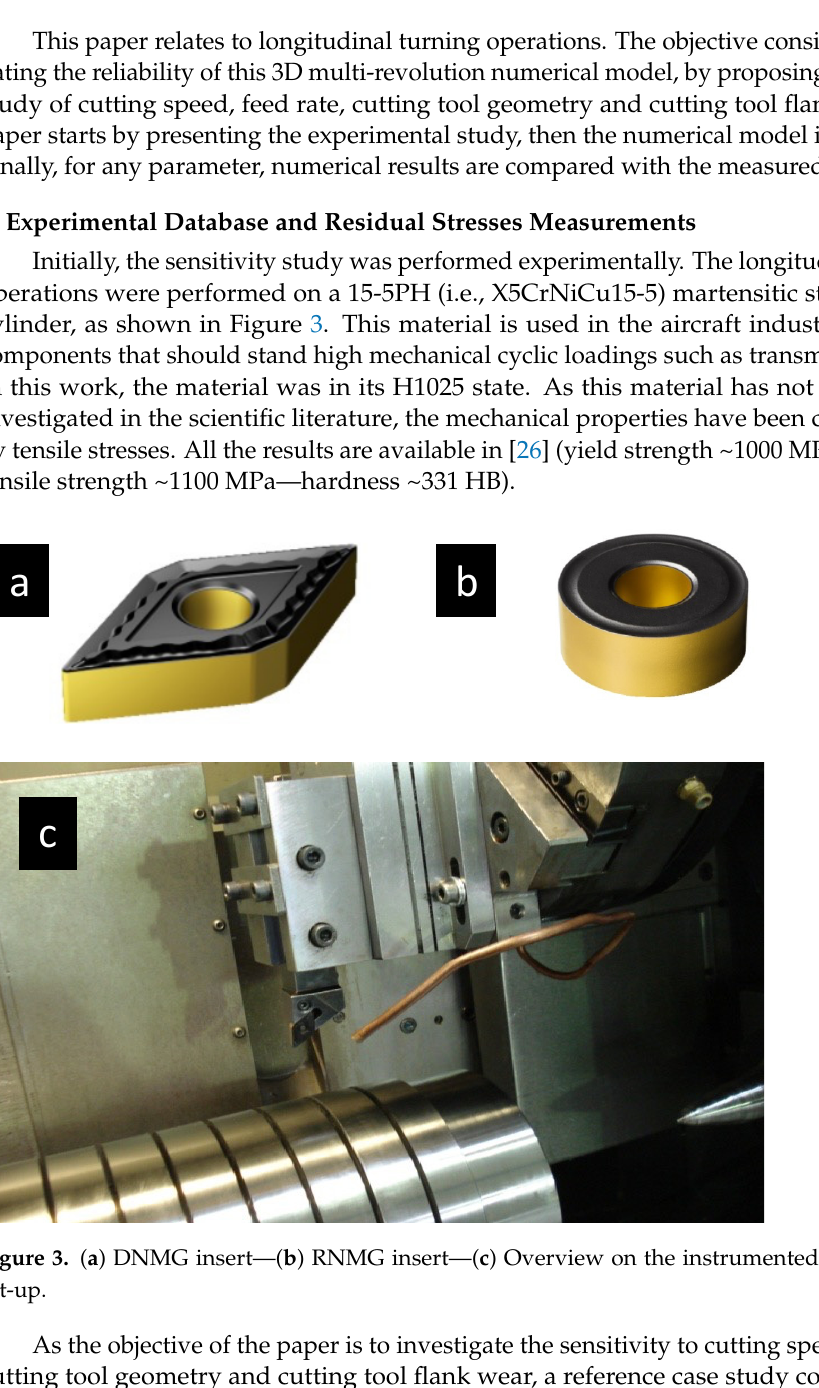
Figure 2. Modelling simplification of a whole turning operation through an elementary volume [26].